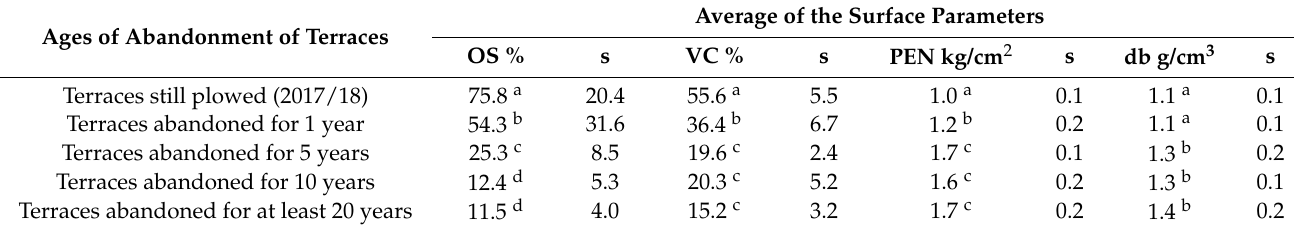
Average of the Surface